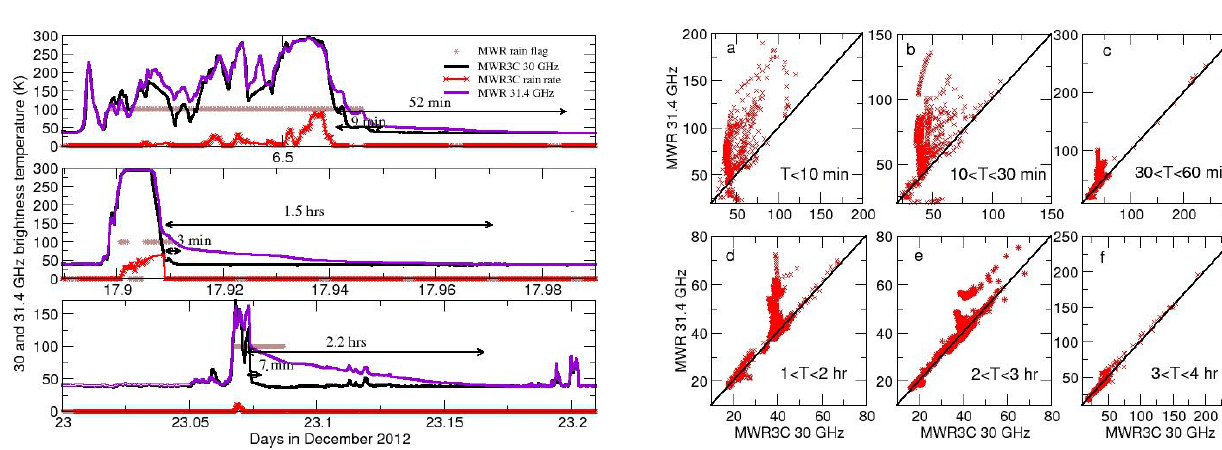
Fig. 7. Three rain events in Gan, Maldives and the effect of the response of the rain mitigation system on the MWR (violet line, 31.4GHz) and the MWR3C (black line, 30GHz). Red crosses are the rain rate (mmh − 1 ) measured by the MWR3C weather station; brown points represent the times when the MWR rain flag was on. The black solid lines indicate the time between the end of the rain (zero rain rate according to the MWR3C) and the return of bright- ness temperatures to approximate pre-rain values.